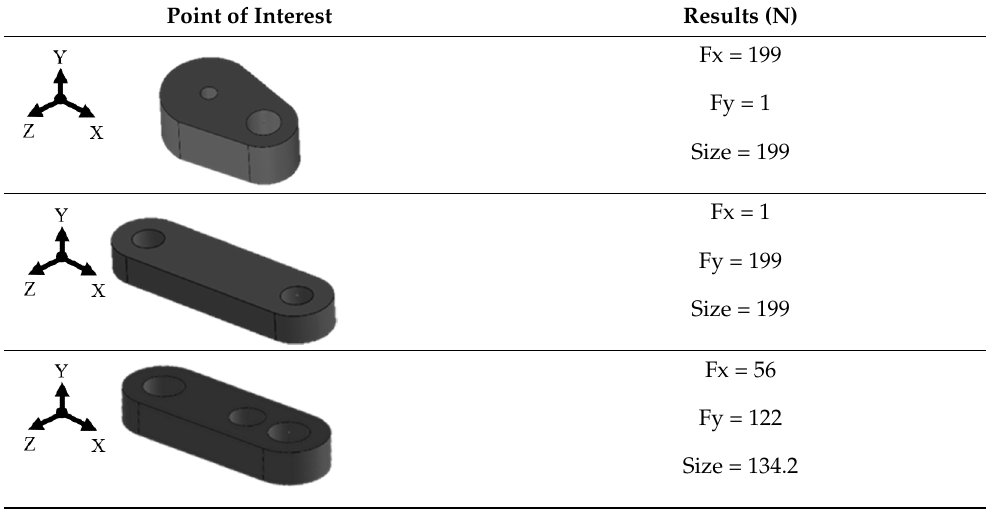
Figure 10. ( a ) The 6-bar mechanism. ( b ) The critical position of the arm.